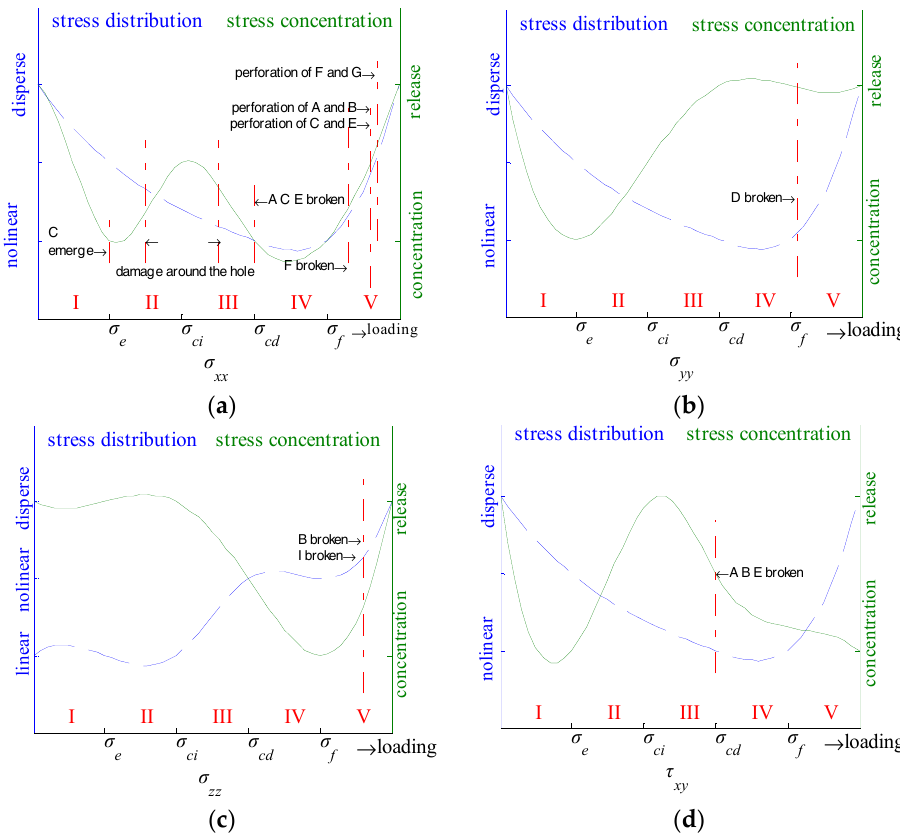
Figure 9. Revolution of stress and failure: ( a ) relationship of σ xx and destruction evolution; ( b ) relationship of σ yy and destruction evolution; ( c ) relationship of σ zz and destruction evolution; and ( d ) relationship of τ xy and destruction evolution.